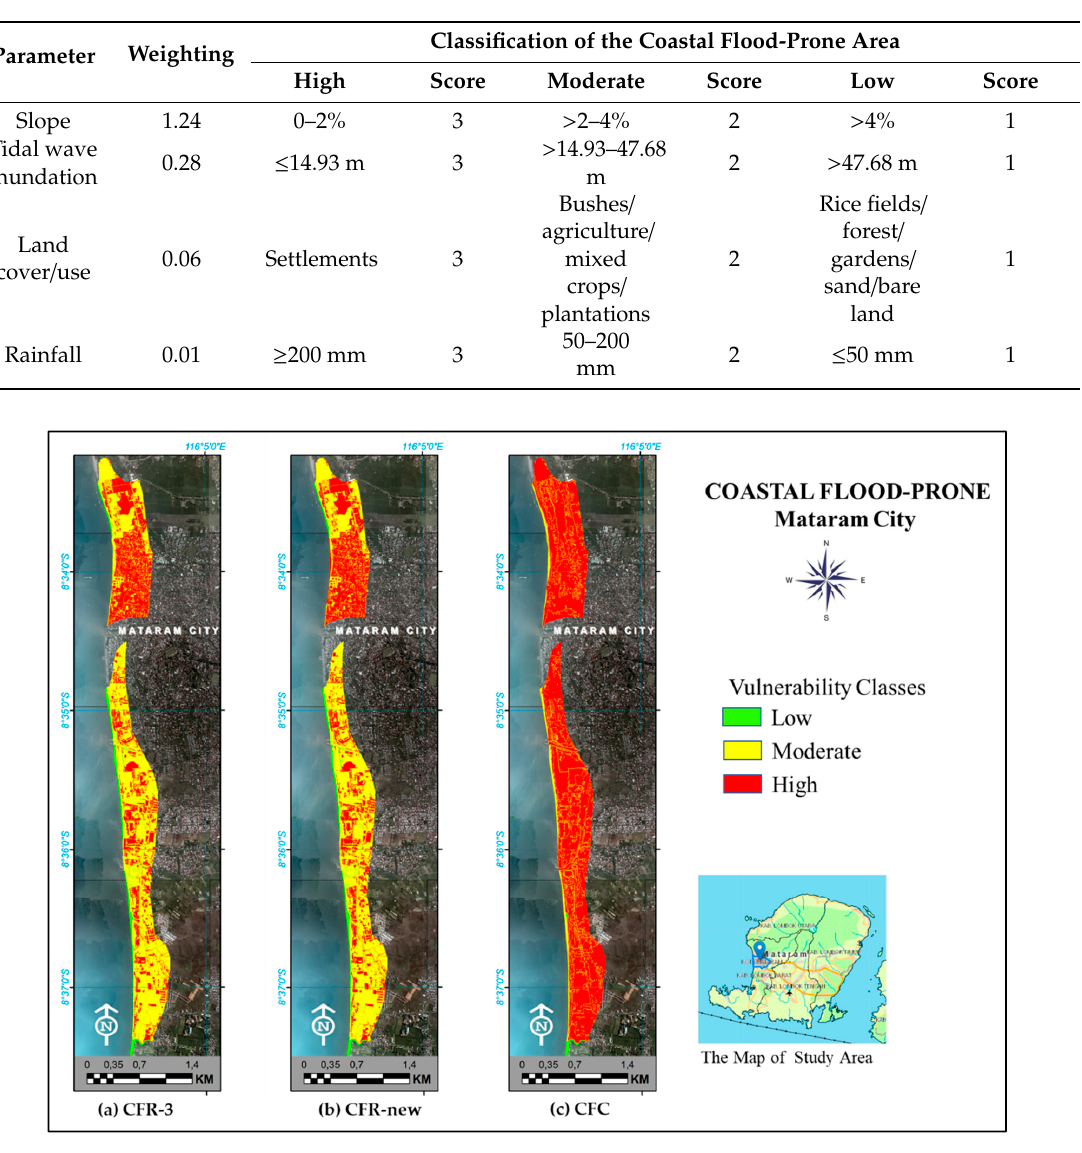
Figure 6. The flood-prone mapping based on CFR-3 ( a ), CFR-new ( b ), and ( c ) coastal flood-prone areas by combined drivers (CFC).